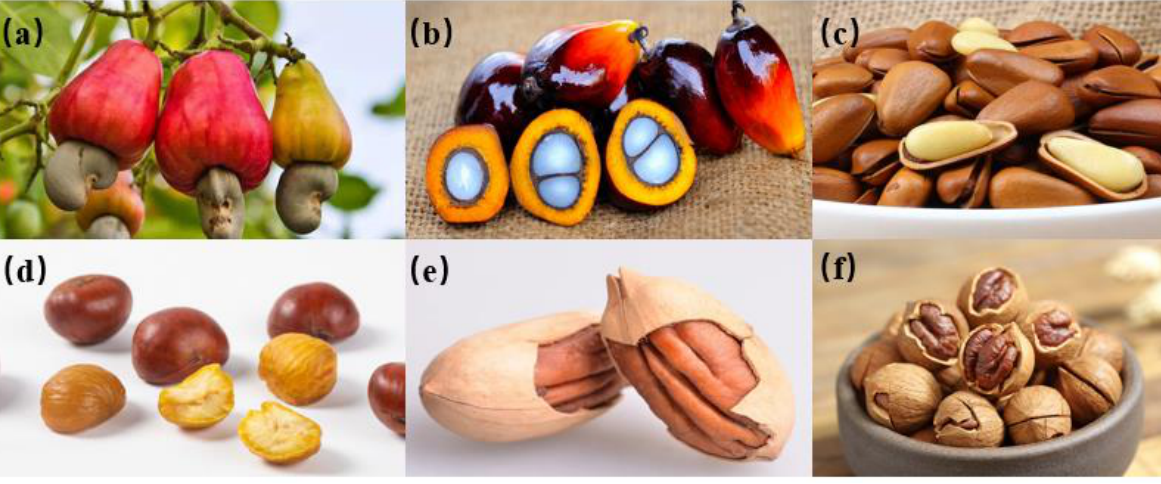
Figure 3. Some breaking fruits ( a ) Cashew nuts. ( b ) Oil palm small fruits. ( c ) Pine nut. ( d ) Chestnuts. ( e ) Bigen fruit. ( d ) Walnut. ( e ) Bigen fruit. ( f )